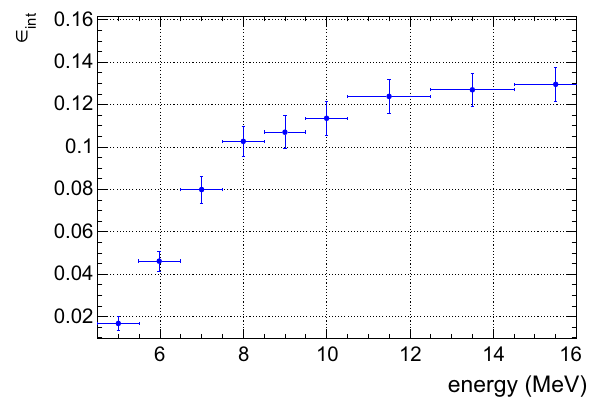
Fig. 9 Reconstructed neutron energy spectrum in the energy range from 5 MeV to 15 MeV (black triangles this work) compared with previous measurements represented by solid triangles: green and pink from[13]andorangefrom[12].Emptycircles,inredandblue,represent the results of the simulations from [11] of Hall A dry and wet concrete respectively. Different energy bins are used by different authors, hence tomakethecomparisoneasier,eachpointinthefigureshowstheintegral flux divided by the bin